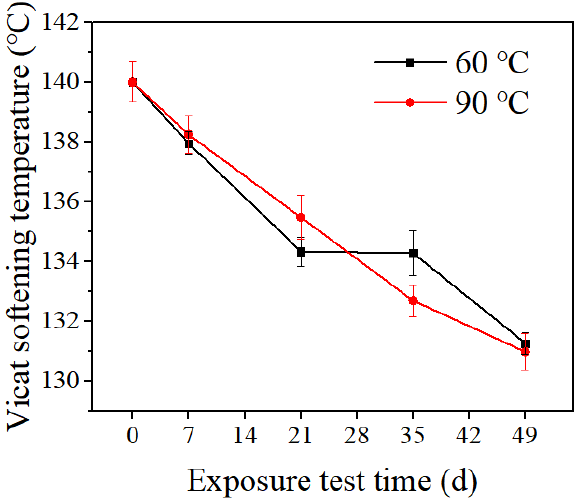
Figure 5. Vicat temperature of PVDF samples after the exposure test.